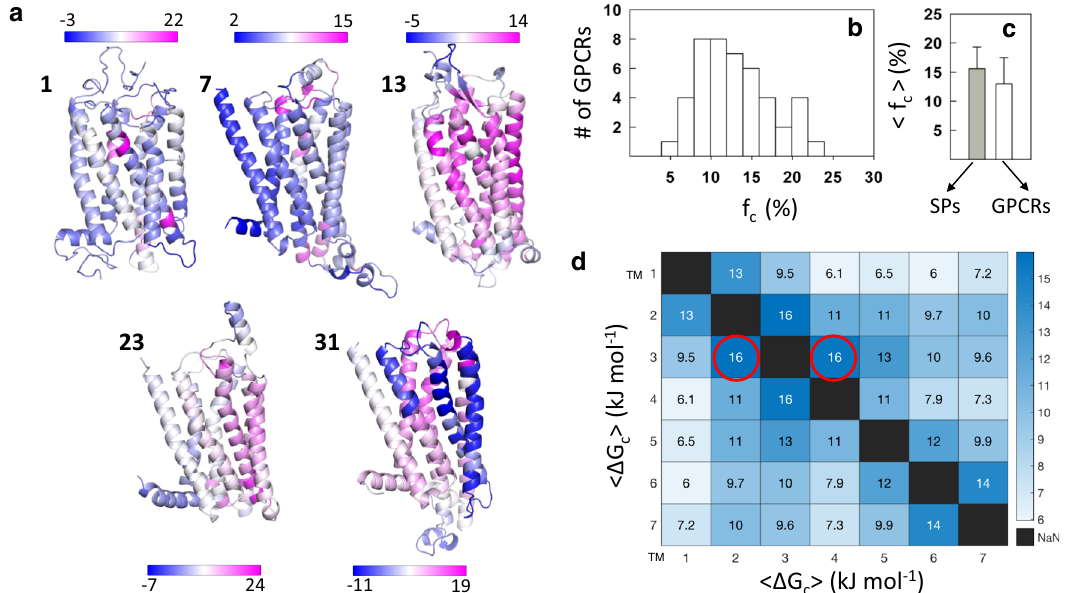
n =25; 15.7±3.7). Data are presented as mean values±one standard deviation. d Effective coupling free energies between transmembrane (TM) helices averaged over the 45 GPCRs. The mean standard deviations in 〈 Δ G c i are of the order of 4 – 6kJmol − 1 ,indicatingsigni fi cantvariability.Despitethisvariability,TM3turnsout to be strongly coupled to every other TM helix. Source data are provided as a Source data fi